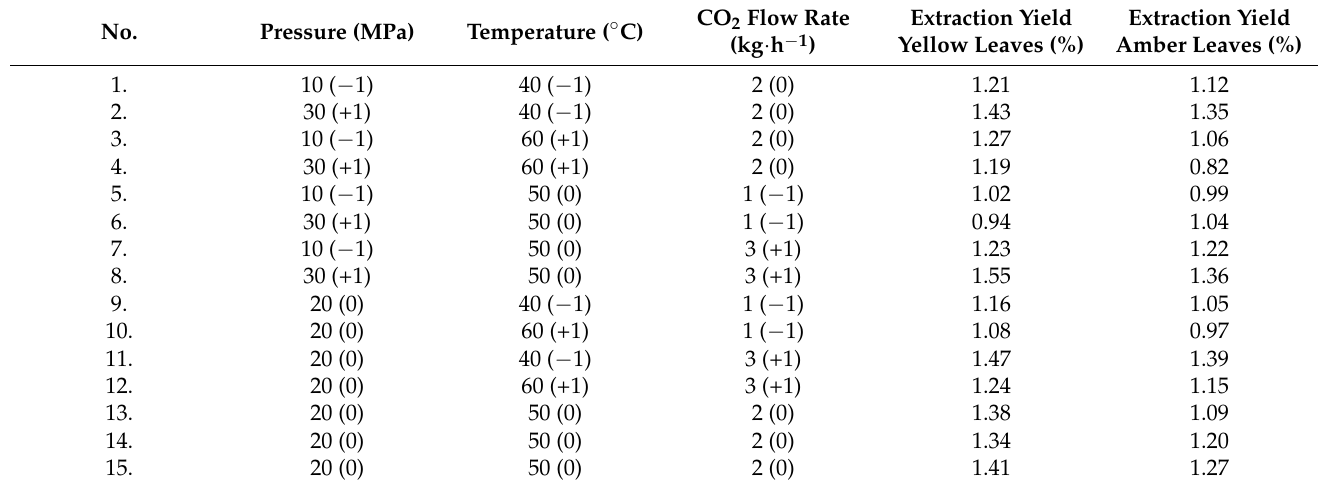
Table 1. The RSM analysis and observed responses for the P. persica yellow and amber leaves’ total extraction yield (%).